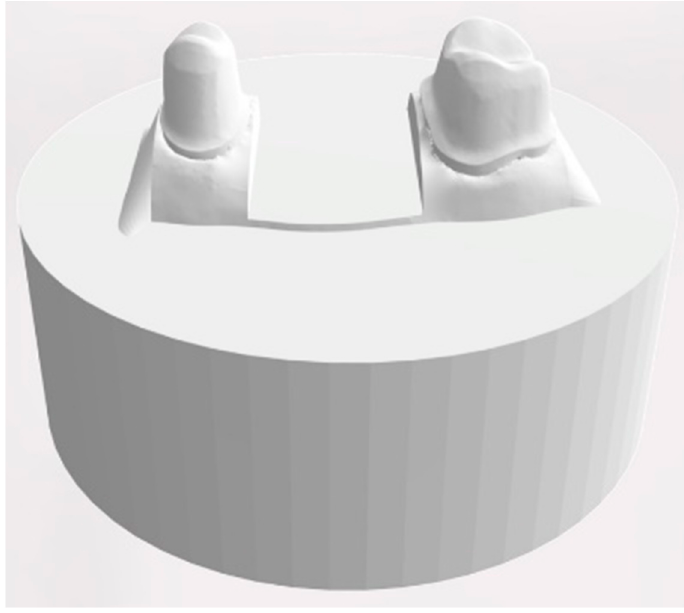
Figure 5. Design of the object holder with two prepared teeth.